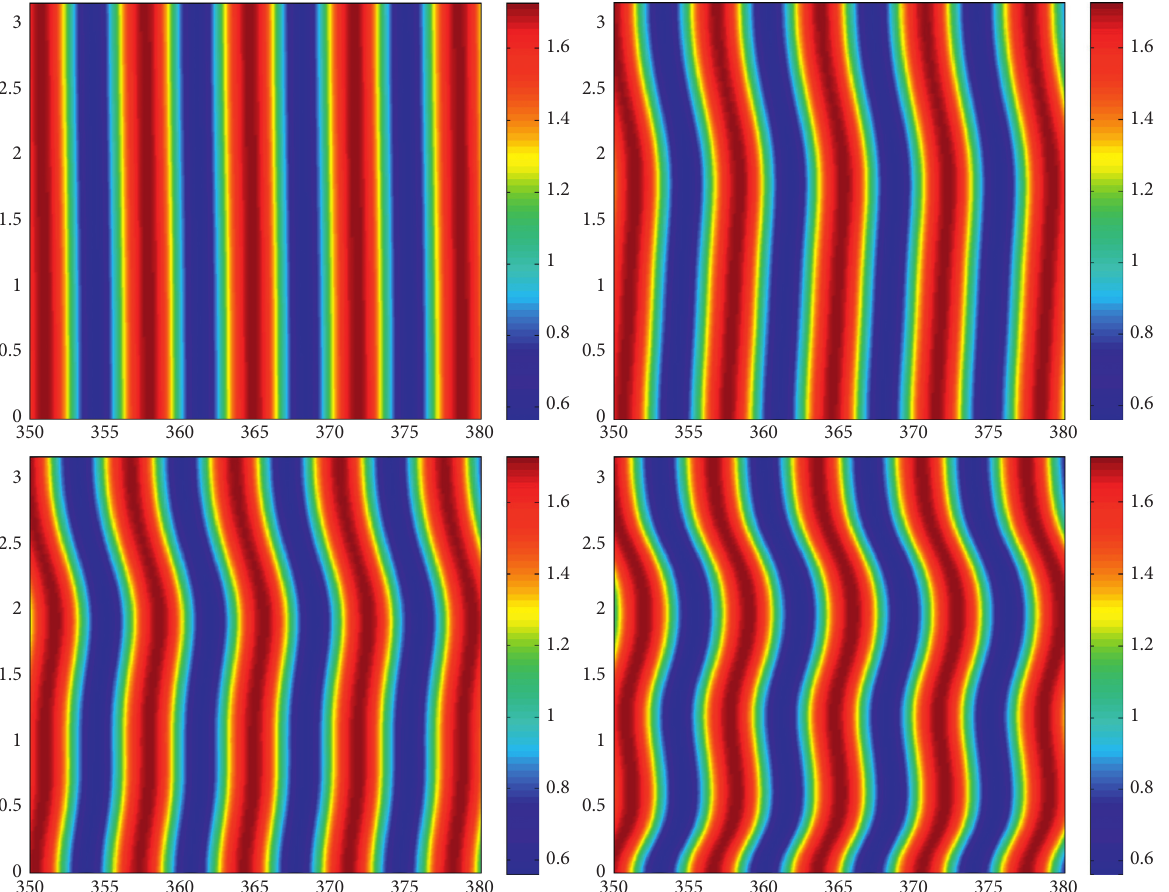
Figure 11: The spatial pattern of the system with Neumann boundary for y � 0 . 01 , 0 . 001 , 0 . 0005 , 0 . D i